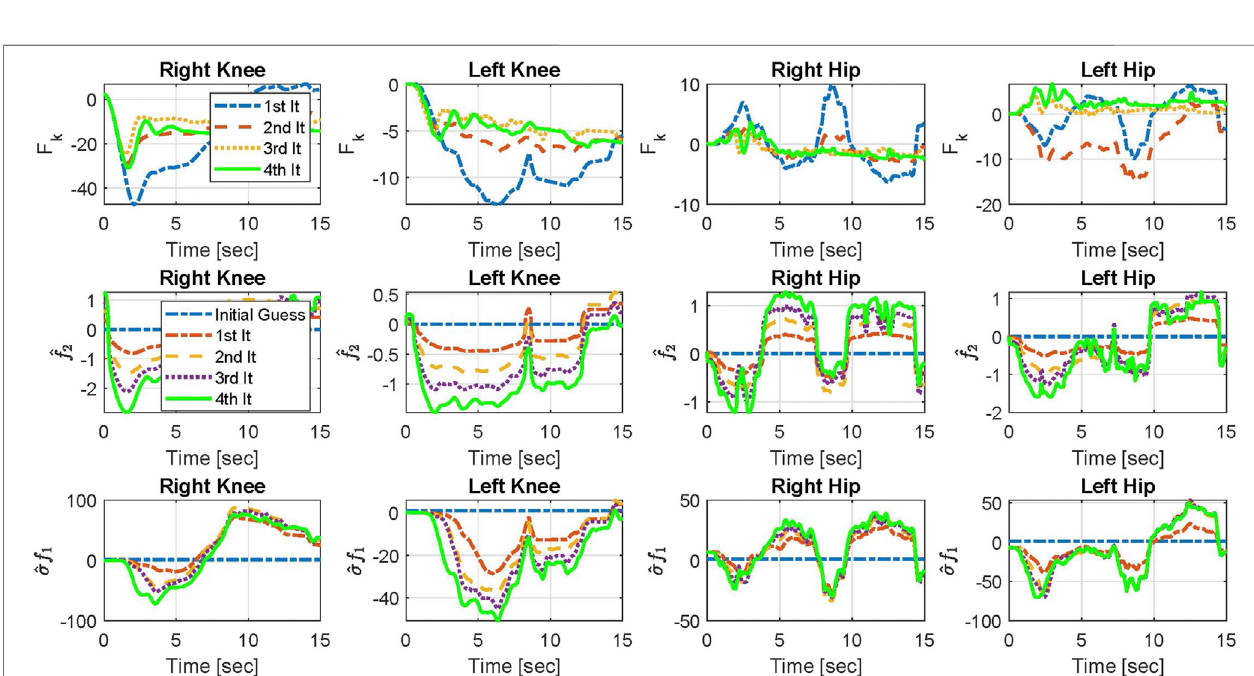
FIGURE 6 | Changes of F k , ^ f 2 , and ^ σ f 1 in the top-level controller for Participant 2 in 4 iterations.